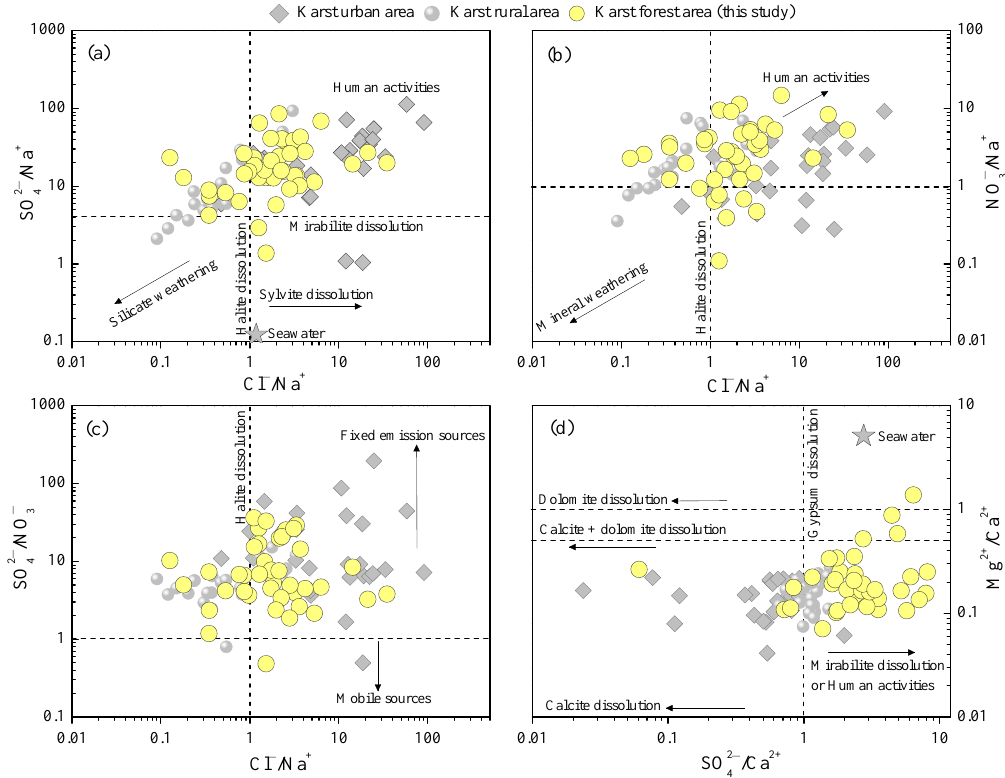
Figure 7. The relationship between the ratios of typical ions (equivalent ratio) in karst forest, urban, and rural rainwater, including SO 42 − / Na + vs. Cl − / Na + ( a ), NO 3 − / Na + vs. Cl − / Na + ( b ), SO 42 − / NO 3 − vs. Cl − / Na + ( c ), and Mg 2 + / Ca 2 + vs. SO 42 − / Ca 2 + ( d ) ratios. The calcite and dolomite dissolution line is the second horizontal dotted line in ( d ), and the calcite dissolution line is the x axis in ( d ). Data sources for karst urban and rural rainwater chemistry and other reference values are from